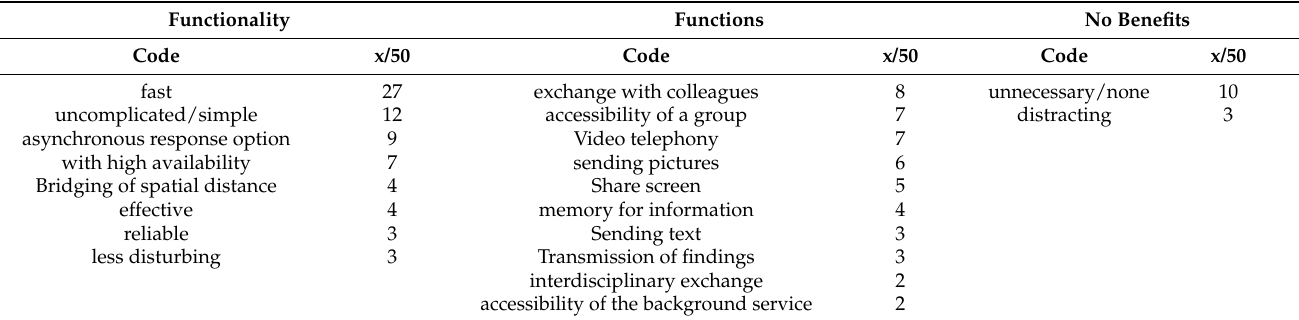
Table 3. Absolute frequencies of the codes assigned (Q16) “What do you see as the benefits of using communication apps in your daily clinical practice?” ( N = 50/70).